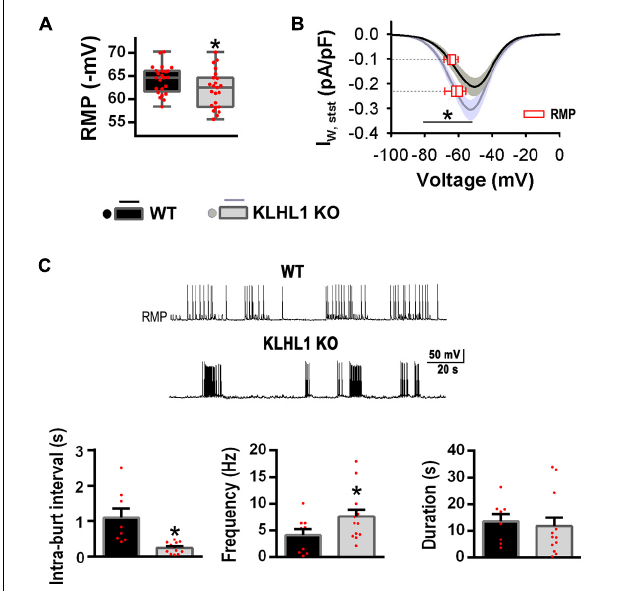
FIGURE 4 | Increased T-type window currents and burst-firing patterns in KLHL1-KO neurons. (A) Resting membrane potential (RMP) in WT ( n = 24) and KLHL1-KO ( n = 23) neurons. * P < 0.05, t -test, t = 2.120 (df = 45). (B) T-type steady-state currents in WT ( n = 18) and KLHL1-KO ( n = 23) neurons. Window currents were calculated for each recording neuron from the SSA and SSI curves fitted to a Boltzmann function; SEM is indicated in gray. The steady-state current at the RMP (empty red box plot) is indicated for both genotypes. * P < 0.05, Two Way ANOVA, F 1 , 139 = 13.468 (from –50 to –80 mV). There is a statistically significant interaction between the genotype and the voltage ( F 11 , 420 = 2.300) (from –20 to –80 mV). (C) Top: Example of firing patterns in WT and KLHL1-KO neurons. Botton: Mean-intraburst interval, frecuency and duration of the burst activity. * P < 0.05, t -test, t = 3.770 for mean-intraburst interval and t = 1.900 for frequency (df = 18, n = 8 for WT, n = 12 for KLHL1 KO).